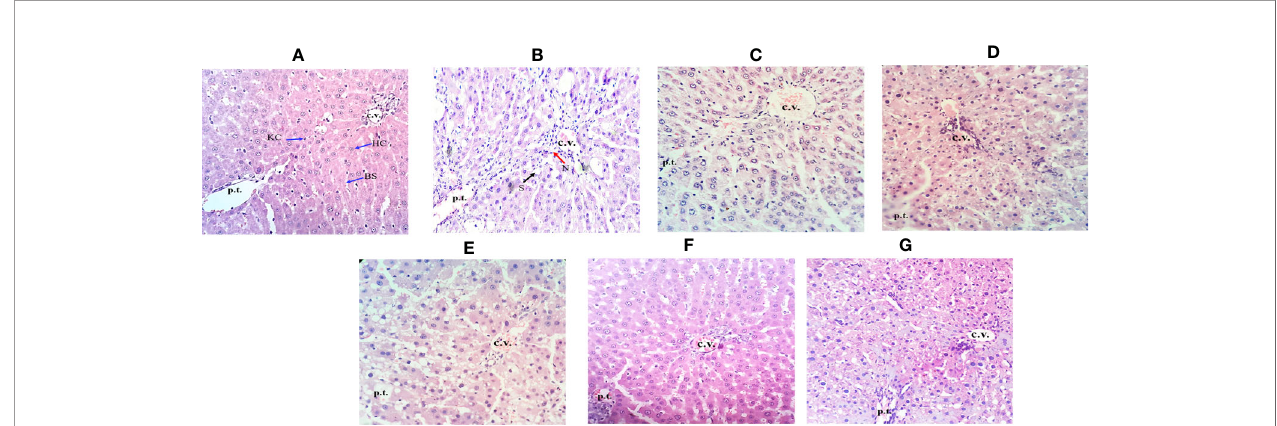
FIGURE 6 | Effect of Obeth from O. bracteata on histology of liver tissues as assessed by H & E staining. (A) Control group (tap water ad libitum) (GI) showing normal lobular architecture with clear portal triad. (B) CCl 4 : Olive oil (1:1; 1mL kg -1 b.wt.) induced necro-in fl ammatory activity in GII was noted. Treatment of Obeth extract was associated with diminution of portal hypertension with increasing dose. (C) Silymarin (100 mg kg -1 b.wt.) + CCl 4 , (D) low dose (50 mg kg -1 b.wt.) + CCl 4 , (E) medium dose (100 mg kg -1 b.wt.) + CCl 4 , (F) High dose (200 mg kg -1 b.wt.) + CCl 4 , (G) Negative (only extract 100 mg kg -1 b.wt. Arrows indicate Kupffer cell (KC), central vein (CV), hepatic cells (HC), blood sinusoids (BS), steatosis (S) (black arrow), and necrosis (N) (red